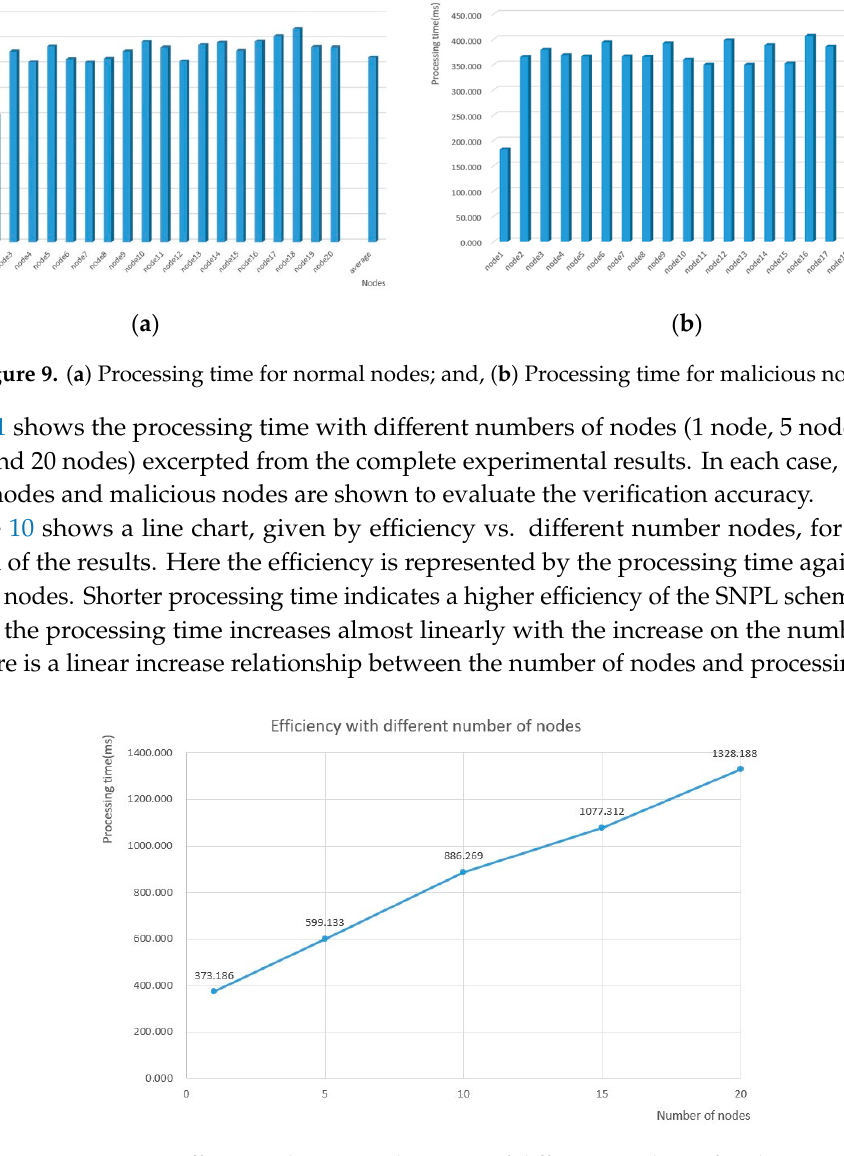
ffi ciency changes in disposing of di ff erent numbers of Figure 10. Efficiency changes in disposing of different numbers of nodes. Figure 10. E